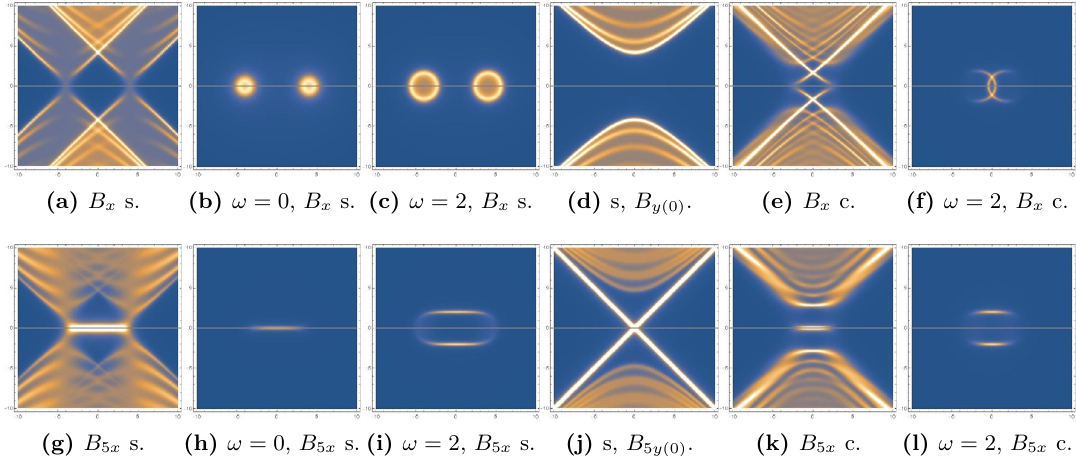
Figure 9. (adgj)Spectral Functions of B x and B 5 x with additional sliced view in k x , k y plane of ω = 0 , 2 slices. Notice that source splits the degenerated Dirac cones. B x has zero modes nut B 5 x does not. In all figures, we used B = 4 for any indices.